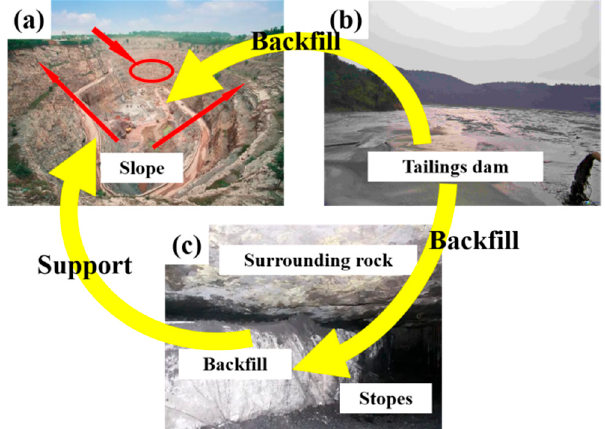
Figure 1. Relationship between slopes ( a ), tailings dam ( b ), and stopes ( c ) in surface and under- ground mining.